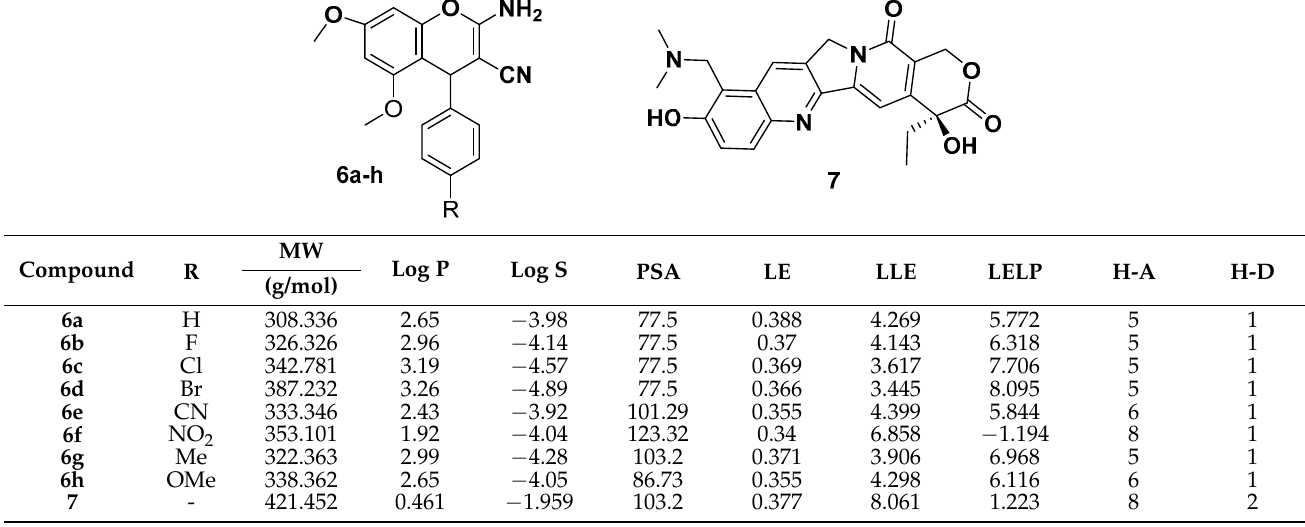
Table 4. Calculated physicochemical properties of 2-amino-3-cyano-4 H -chromenes 6a–h and topotecan 7 as inhibitors of topoisomerase I.